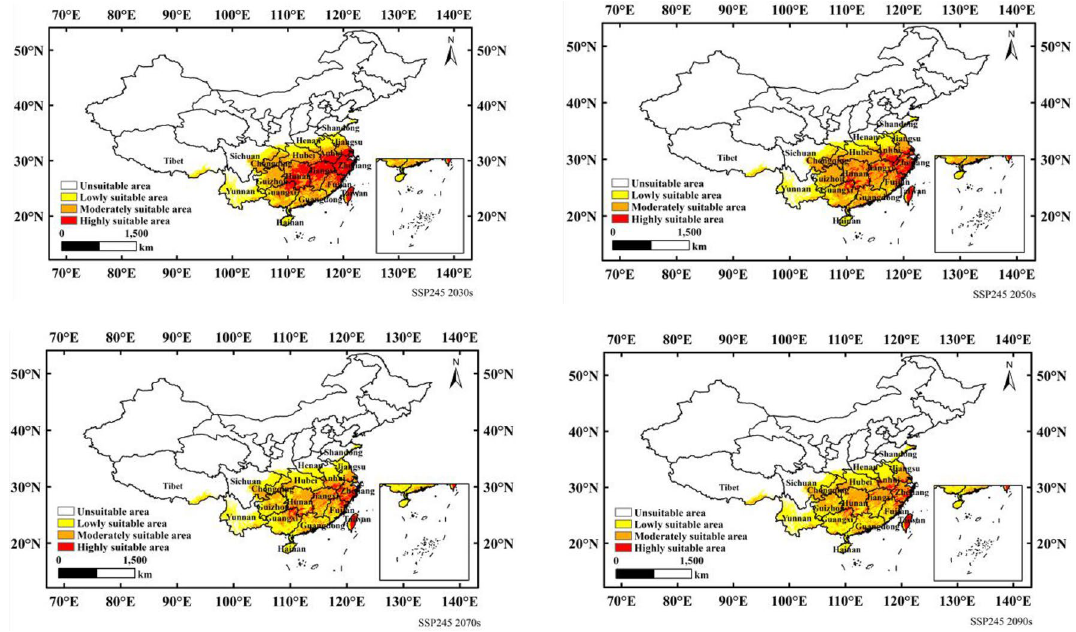
Figure 6. Potential suitable distribution of N. californicus in China based on MaxEnt under scenario of SSP245. Created in ESRI ArcMap 10.8.1 (https:// suppo rt. esri. com/ en/ Produ cts/ Deskt op/ arcgis- deskt op/ arcmap).